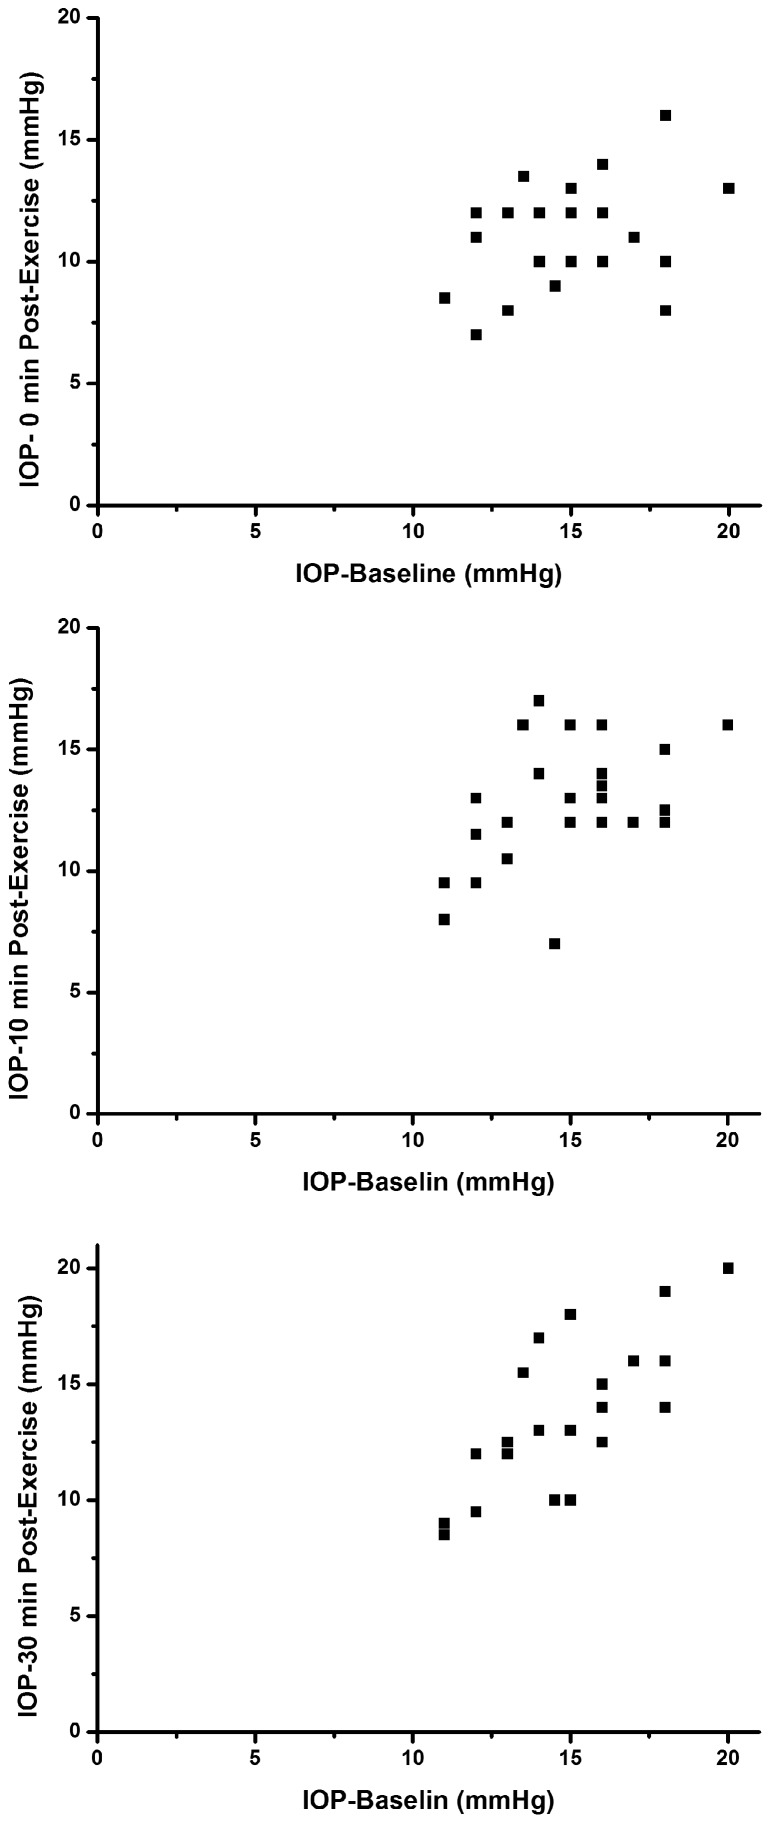
IOP scatterplot before and after exercise.